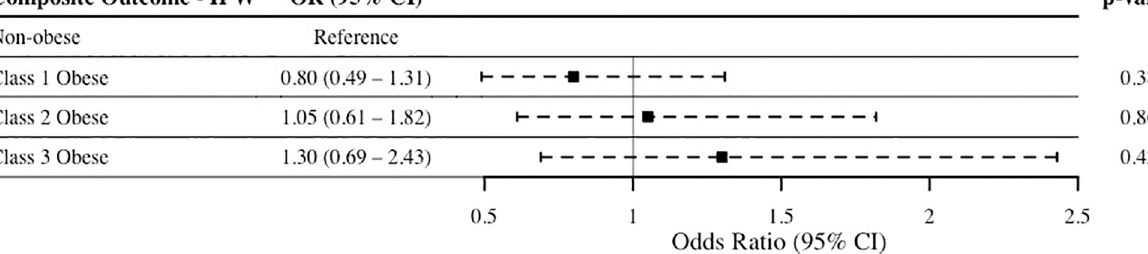
Fig 1. IPW-adjusted logistic regression of composite outcome. Composite outcome represents readmission, reoperation, or complications. Outcome regressed on obesity categories, with non-obese (BMI < 30 kg/m 2 ) patients used as the reference group. Abbreviations: IPW, inverse probability-weighing; OR, odds ratio; CI, confidence interval.